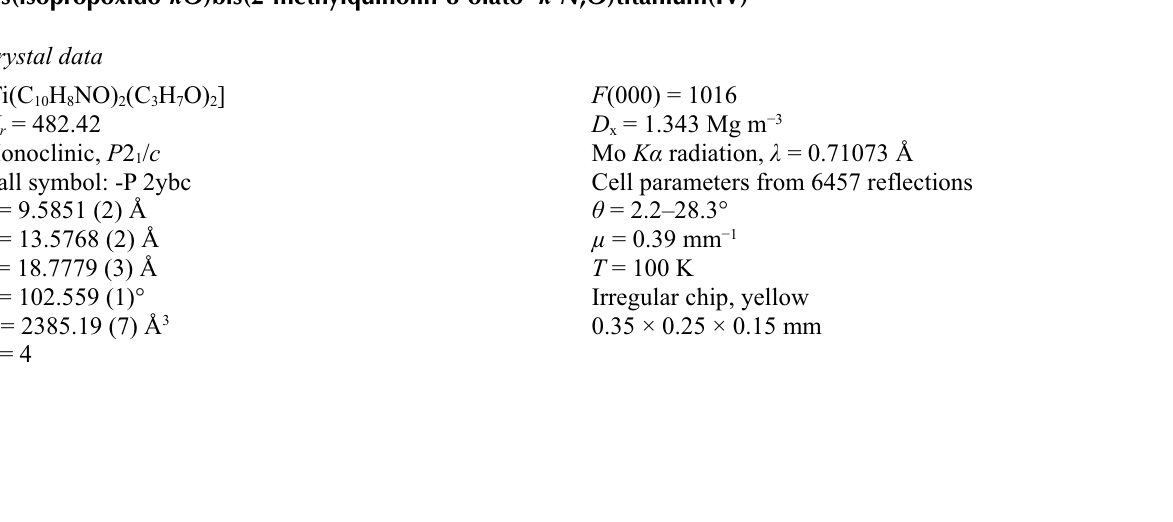
Thermal ellipsoid plot (Barbour, 2001) of Ti(C Hydrogen atoms are drawn as spheres of arbitrary